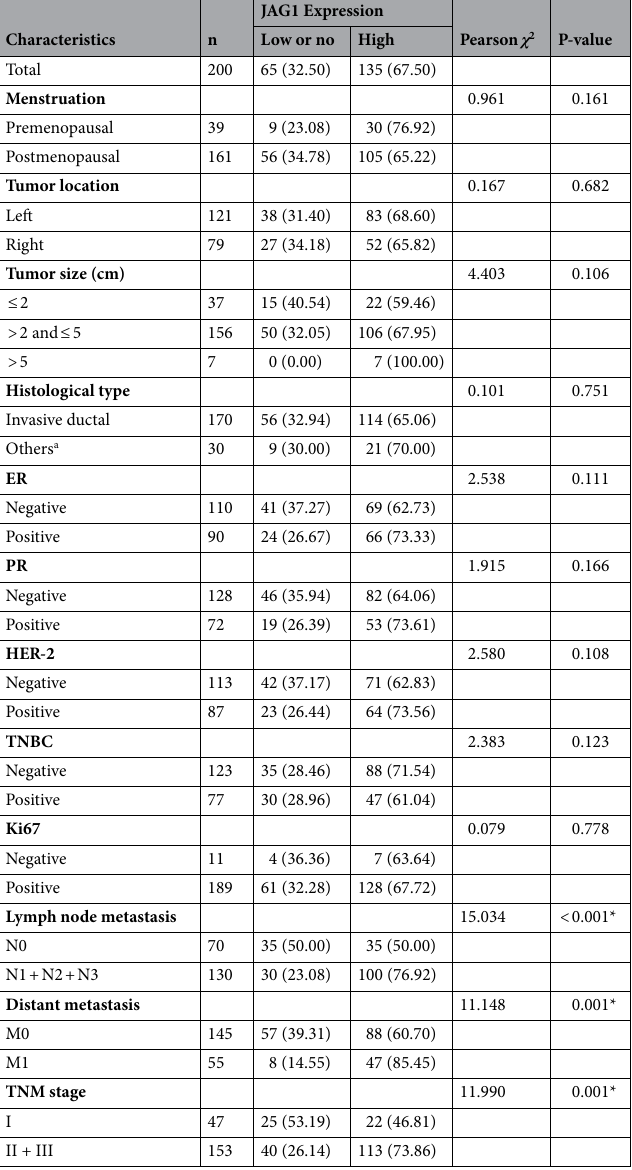
Table 1. JAG1 protein expression level and BC patient clinicopathological characteristics. a Others include ductal in situ in 20 cases, papillary in 4 cases, and mucinous in 6